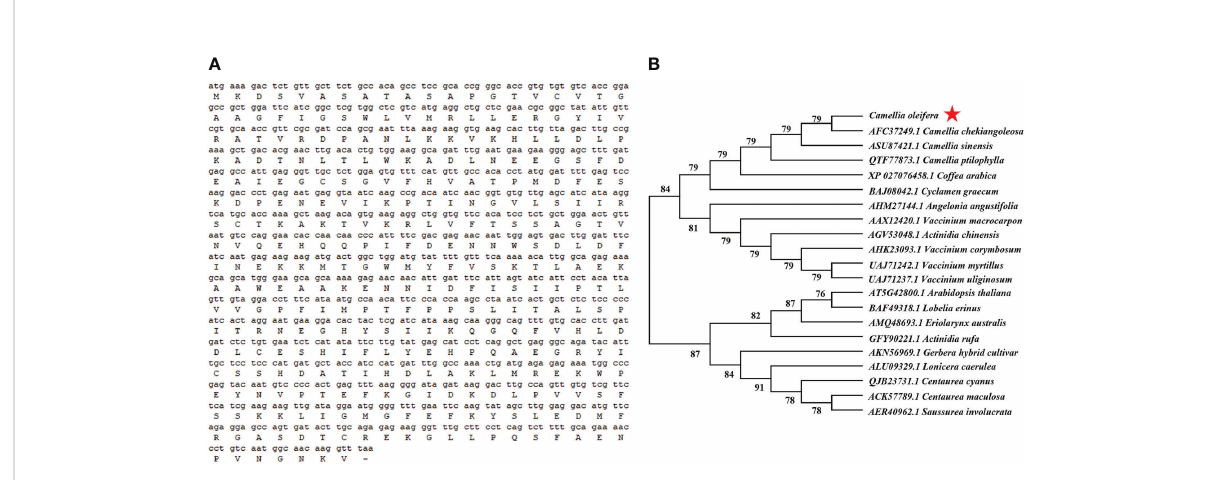
FIGURE 2 (A) The CDS and amino acid sequences of CoDFR . (B) The phylogenetic tree analysis of CoDFR.